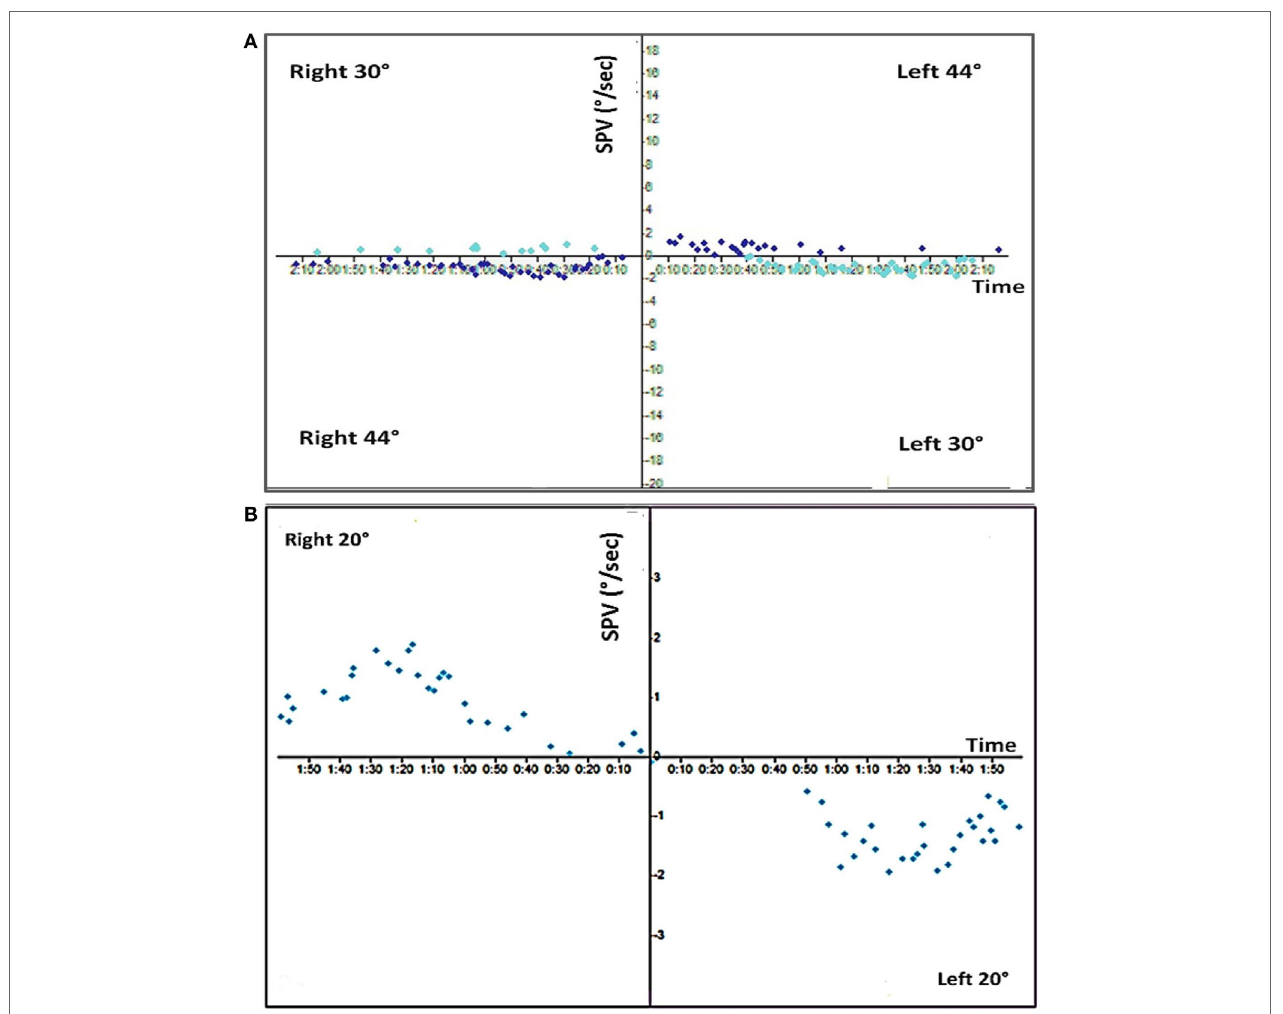
FIgURe 1 | Caloric exam. (a) Top, the standard bithermal caloric test showed no response to either temperature irrigation from either ear. (B) Bottom, ice water irrigation (20°C) shows only a minor residual response (total response =